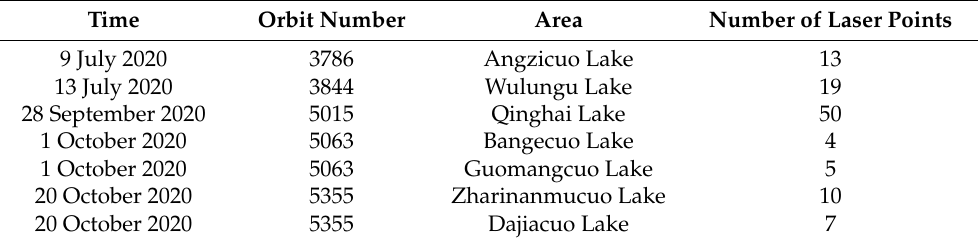
Table 6. Statistics of the experimental data from water areas. Time Orbit Number Area Number of Laser